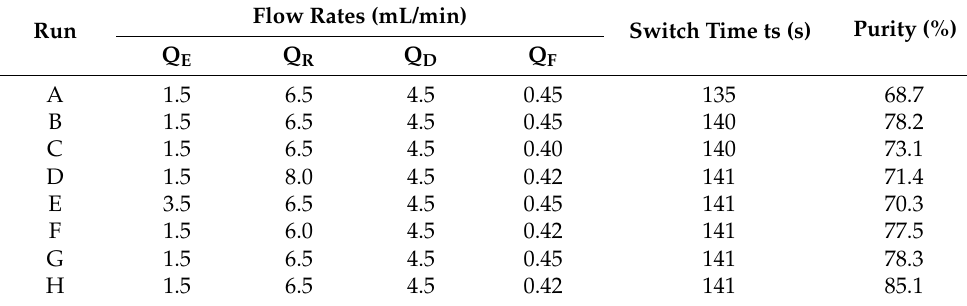
Table 1. Operation parameters and separation performance of the